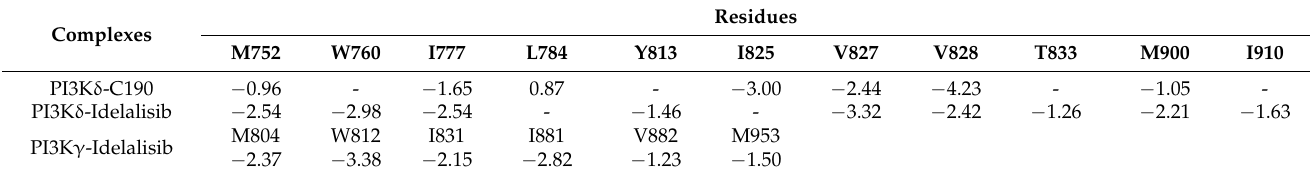
Table 5. Per-residue MM-PB/GBSA binding energy decomposition in kcal/mol.